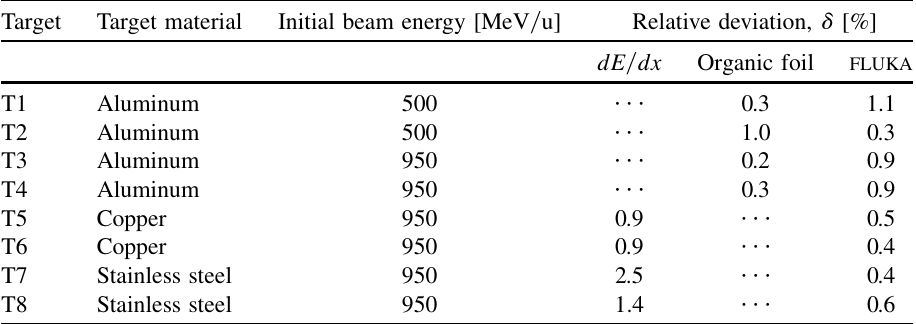
TABLE VI. Relative deviations between the uranium-beam ranges determined by different methods with respect to the range determined by the depth-profiling